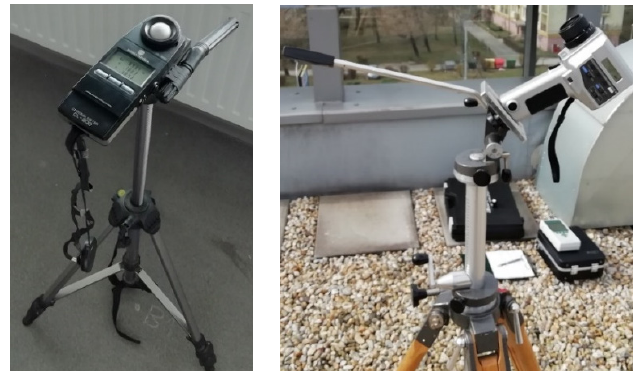
Figure 7. Equipment used for